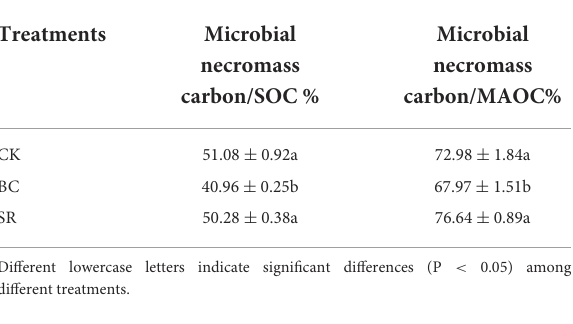
TABLE 5 The ratio of microbial necromass carbon accounting for SOC and MAOC.